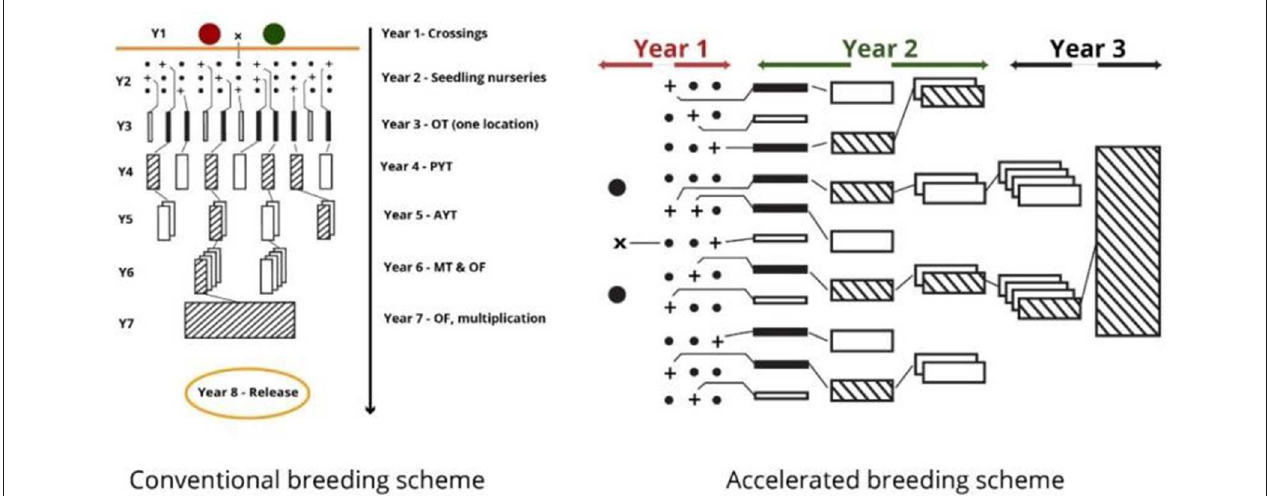
FIGURE 1 | The conventional (left) and accelerated breeding (right)